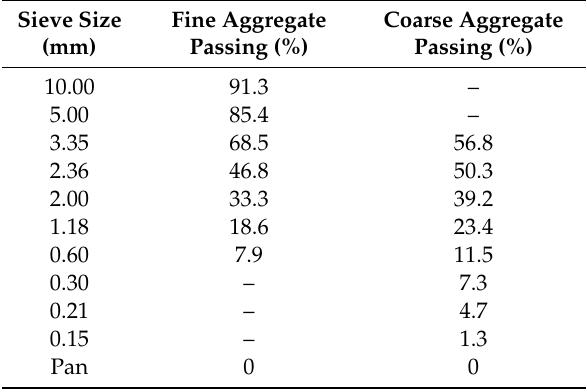
Figure 1. Materials used in the experiment. Table 2. Grading of the coarse and fine Table 1. Chemical characteristics of cement.